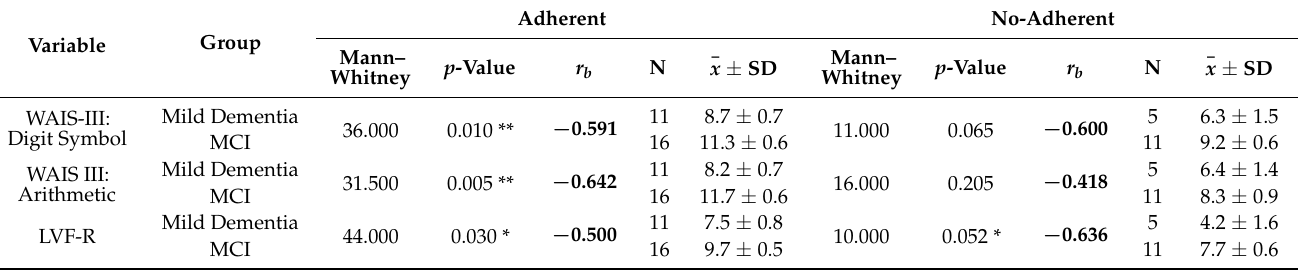
Table 4. Mann–Whitney U test. Comparison between people with MCI and mild dementia in relation to each group (adherent and